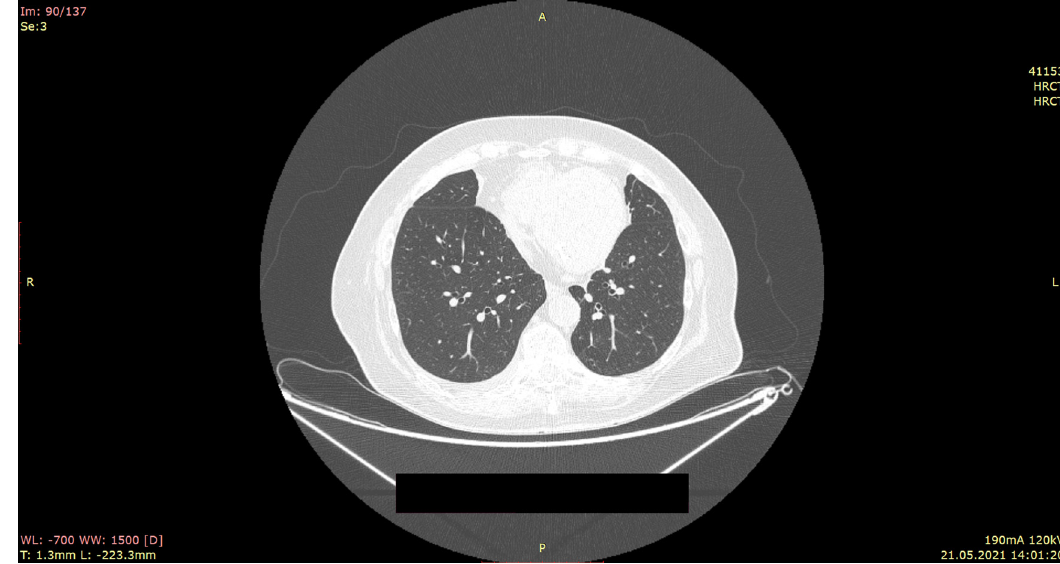
Figure 2: HRCT scans after antifungal treatment: regression of changes visible on admission is